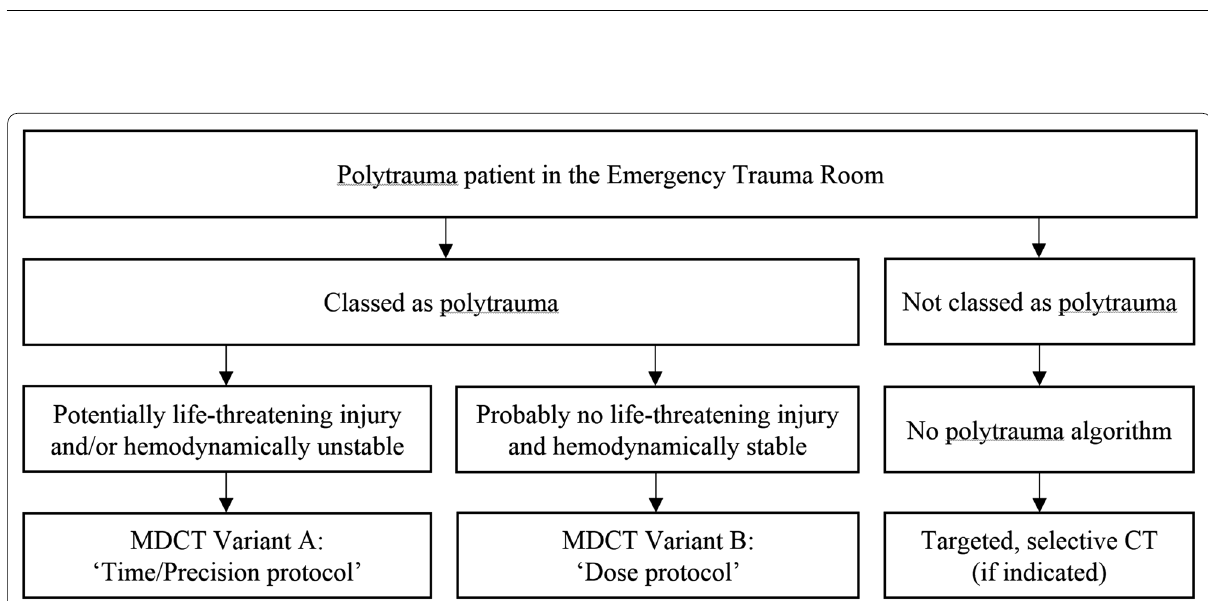
Fig. 1 Decision guidance for polytrauma CT imaging. First, a potential polytrauma patient should be re‑evaluated in the Emergency Trauma Room whether the criteria for a classification as polytrauma (Table 1) is given. If so, and in the case of a severe clinical presentation with life‑threatening injuries and/or haemodynamic instability, the polytrauma ‘Time/Precision protocol’ (whole‑body CT (WBCT) variant A) is applied. If the patient is also classed as polytrauma but does not fulfil criteria for MDCT protocol variant A, the ‘Dose protocol’ (WBCT variant B) may be used. Otherwise,